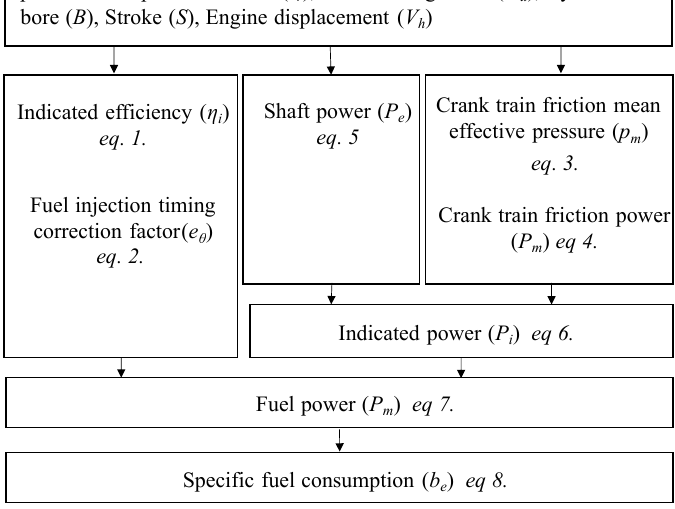
Figure 3. Calculation program structure and calculation